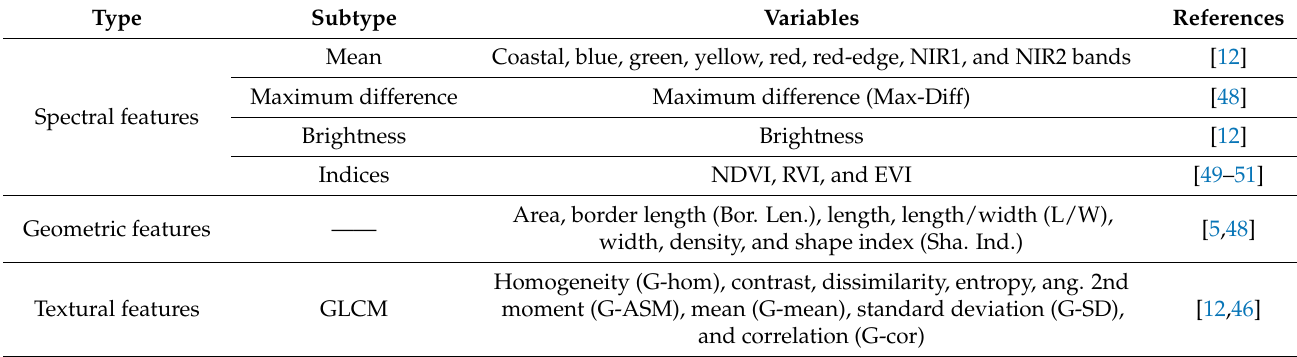
Area, border length (Bor. Len.), length, length/width (L/W), —— width, density, and shape index (Sha.